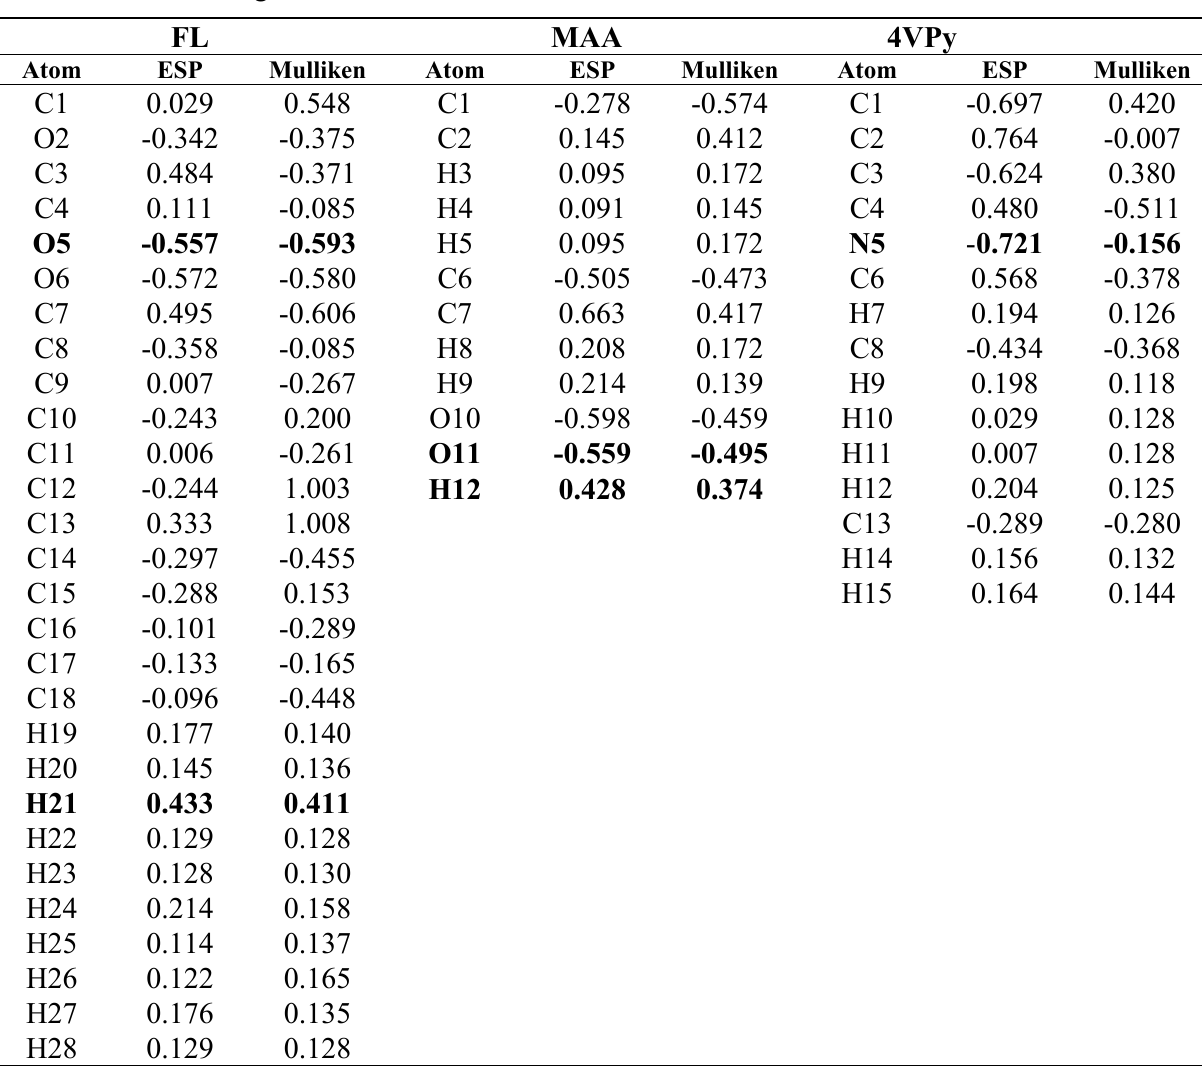
Table 2. ESP and Mulliken charges distribution for the isolated molecules of flavonol (FL), methacrylic acid (MAA) and 4-vinylpyridine (4VPy), without solvent effect. Labels are referred to Figure